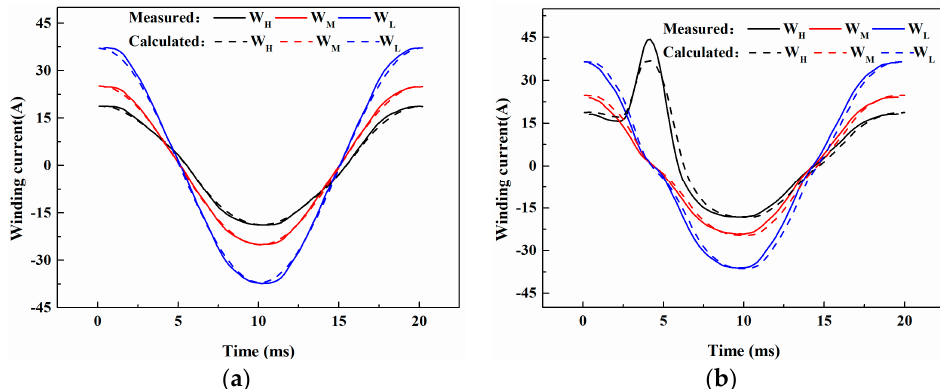
Figure 16. The winding current of calculated and measured with and without DC bias current. where WH presents high voltage winding, WM presents middle voltage winding, WL presents low voltage winding. ( a ) without DC bias current. ( b ) with 5 A DC bias current.